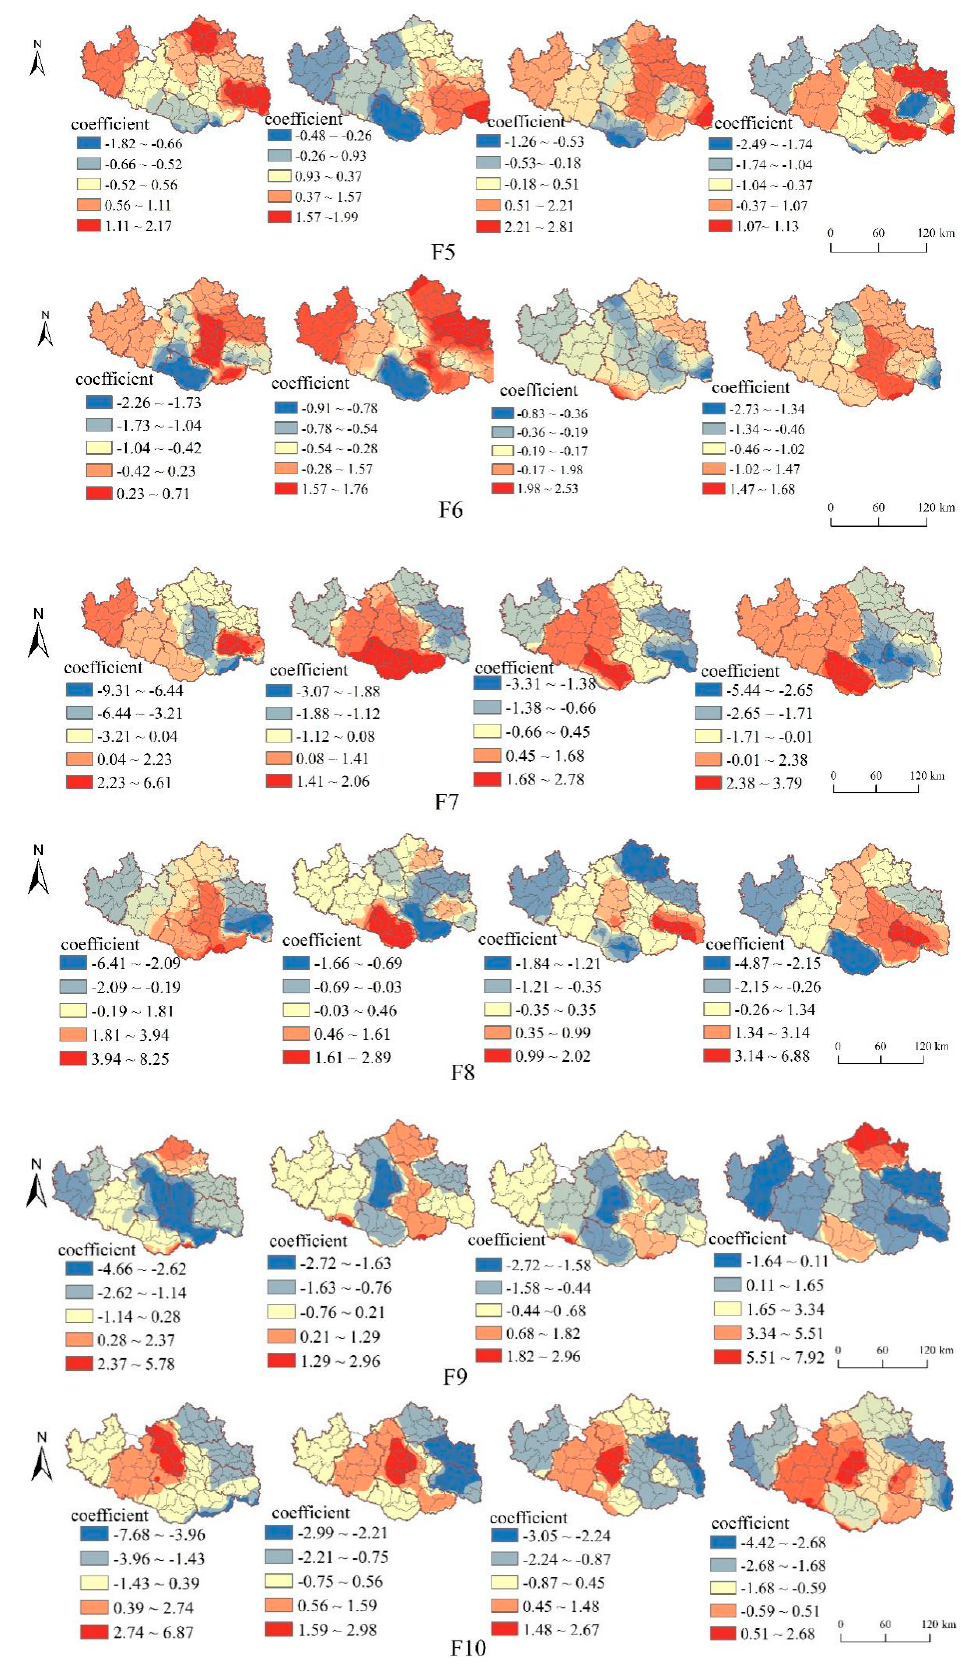
Figure 7. Spatio-temporal variation pattern of dominant factor coefficient of gully farmland